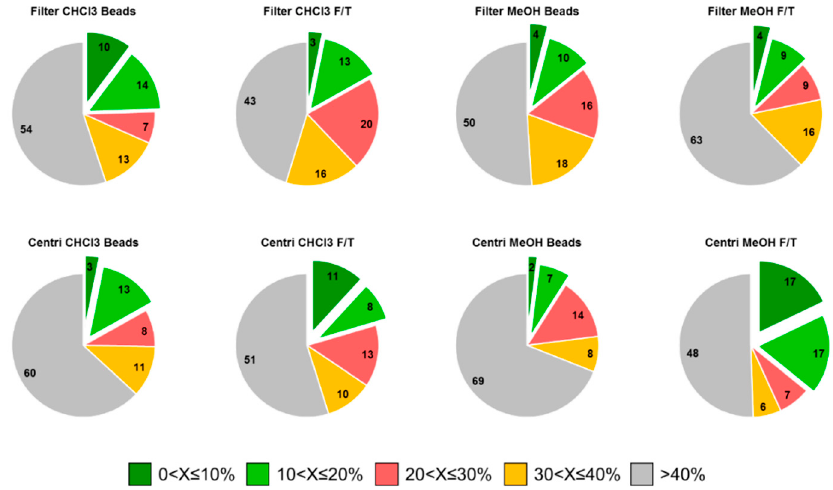
Figure 5. Relative standard deviation (RSD) values calculated on the area reached by each detected metabolite for the eight sample preparations investigated. RSD (X) are classified into 5 categories: 0 < X ≤ 10%, 10 < X ≤ 20%, 20 < X ≤ 30%, 30 < X ≤ 40%, or >40%.